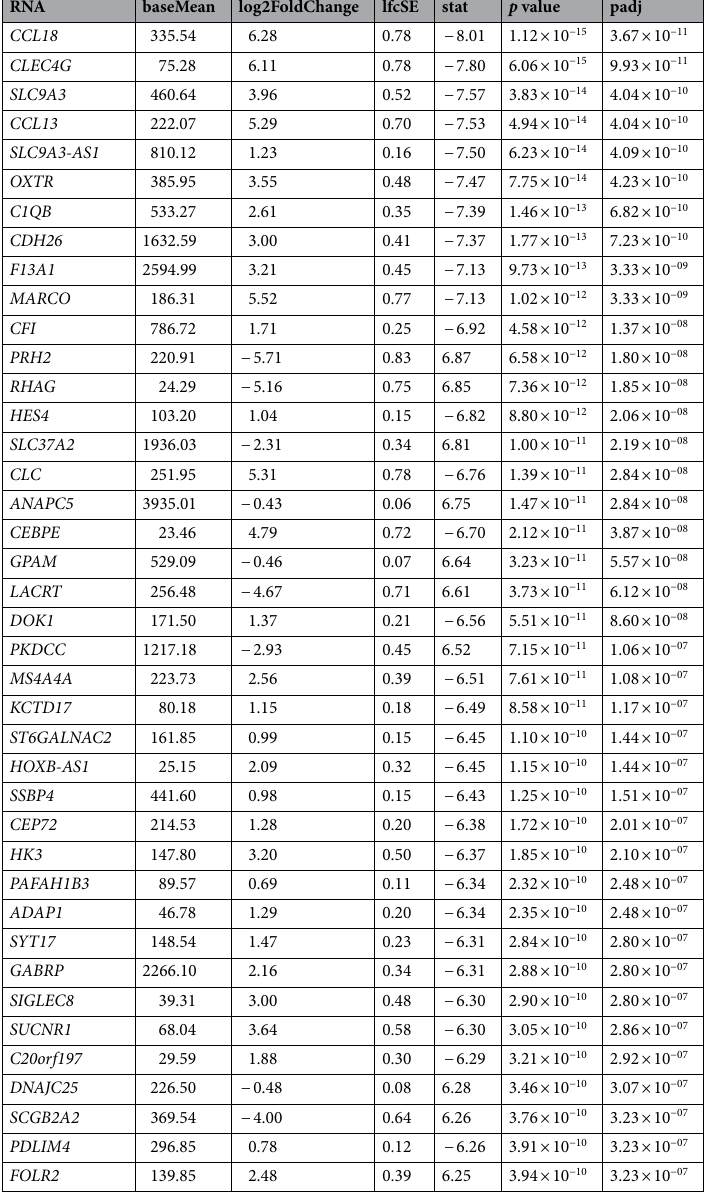
Table 1. The 40 top differentially expressed genes (DEGs) in non-polyp nasal epithelial mucosa from patients with CRSwNP versus polyp mucosa in the same patient. The mRNA levels (baseMean) of expressed genes and p-values adjusted using the Benjamini–Hochberg method. BaseMean mean RNA count, lfcSE log2 Fold Change Standard Error, stat Wald statistic Z-score, padj p -value